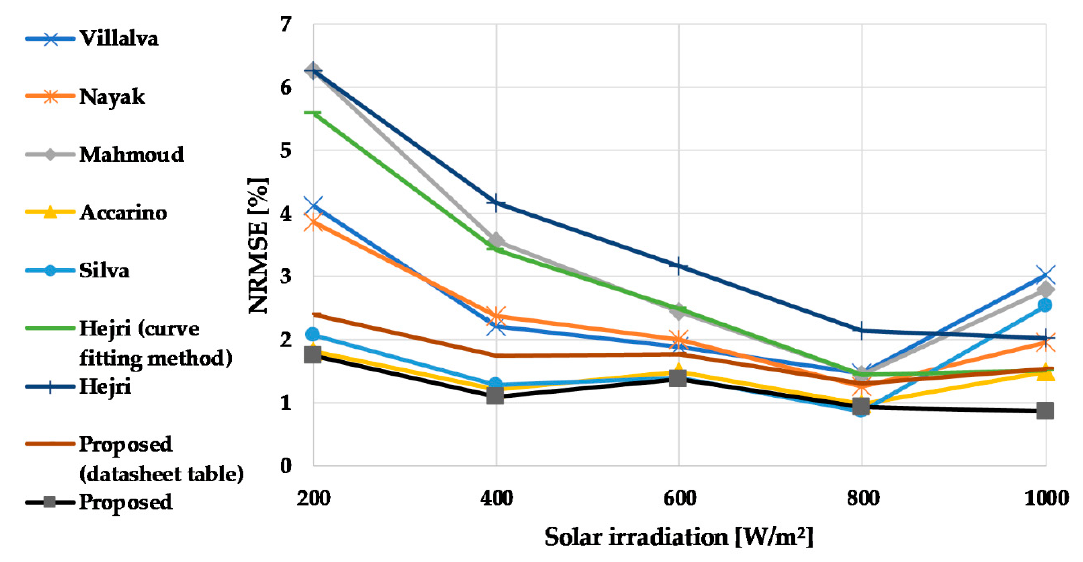
Figure 8. Normalized error pattern for all the examined methods for different solar irradiance values.